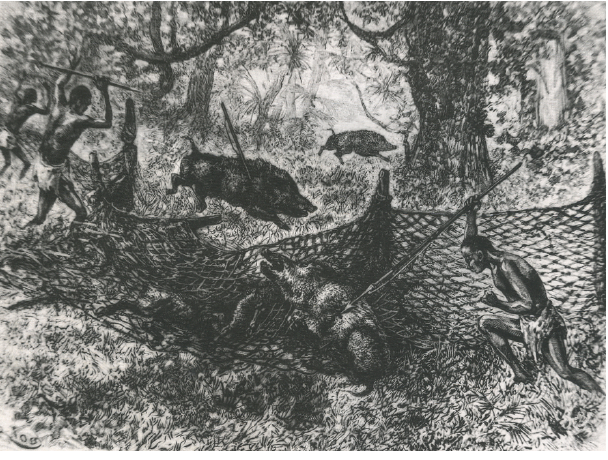
Fig. 5 . Net hunting. Hand-carved engraving by Edouard